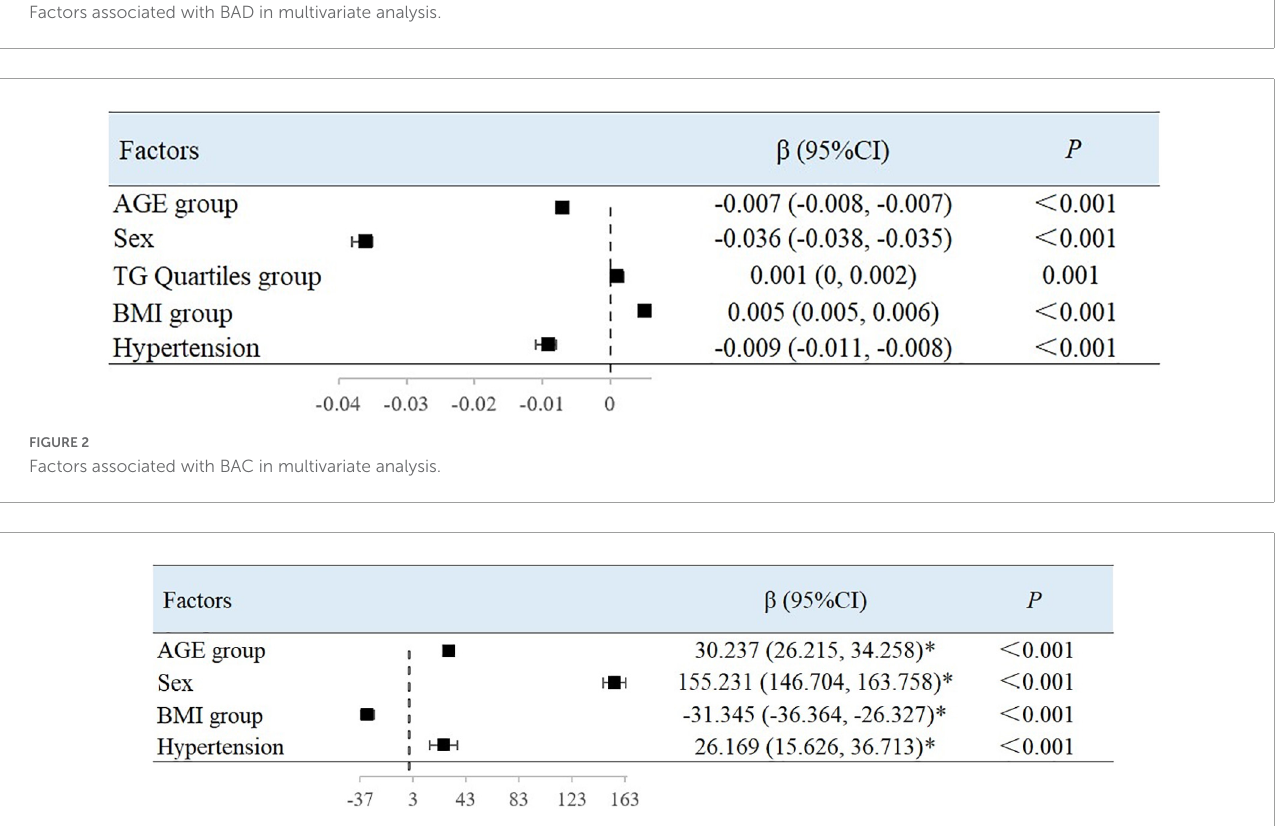
FIGURE3 Factors associated with BAR in multivariate